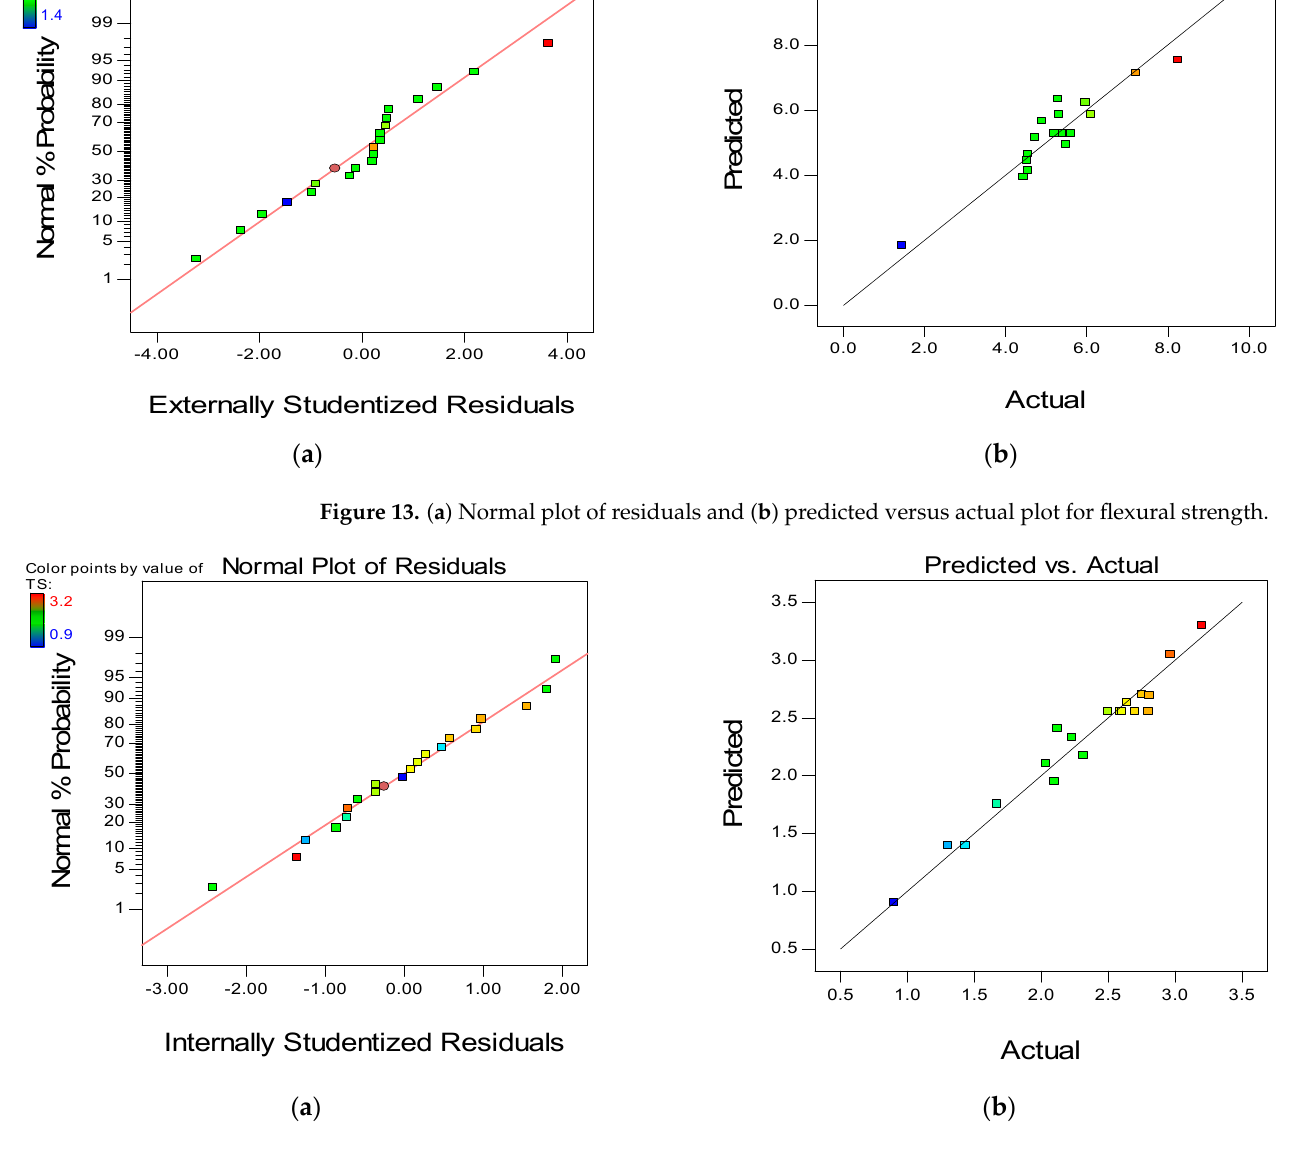
Figure 14. ( a ) Normal plot of residuals and ( b ) predicted versus actual plot for tensile strength. The influence of the input variables’ interaction on the responses is presented using the 2D contour plots and the 3D response surface diagrams. Figures 15–17 show the response surface diagrams for the CS, FS, and TS models, respectively. For a three-input variables situation such as the current research, the interaction of two variables is represented while keeping the third variables constant. In this scenario, the 2D contour plots and 3D response diagrams for the interaction between the FA and CR are provided at a constant value of the NS (set at the highest level of 4